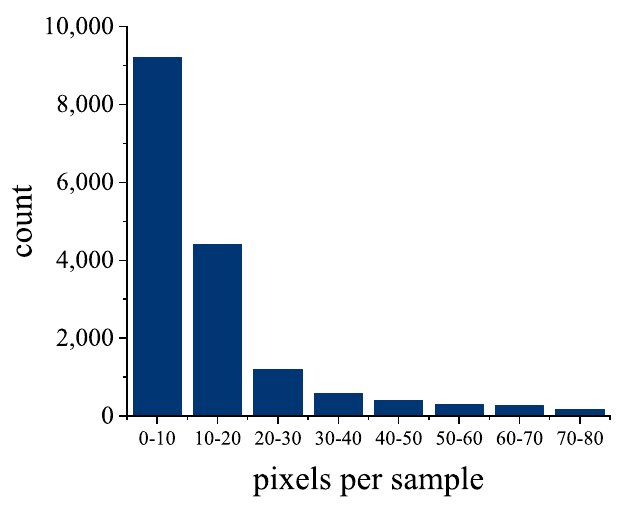
Figure 7. Sizes of objects in the dataset.